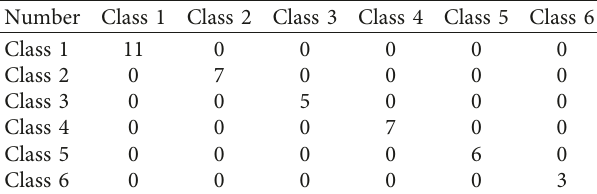
Table 6: The classification results of SVM models in the validation set.